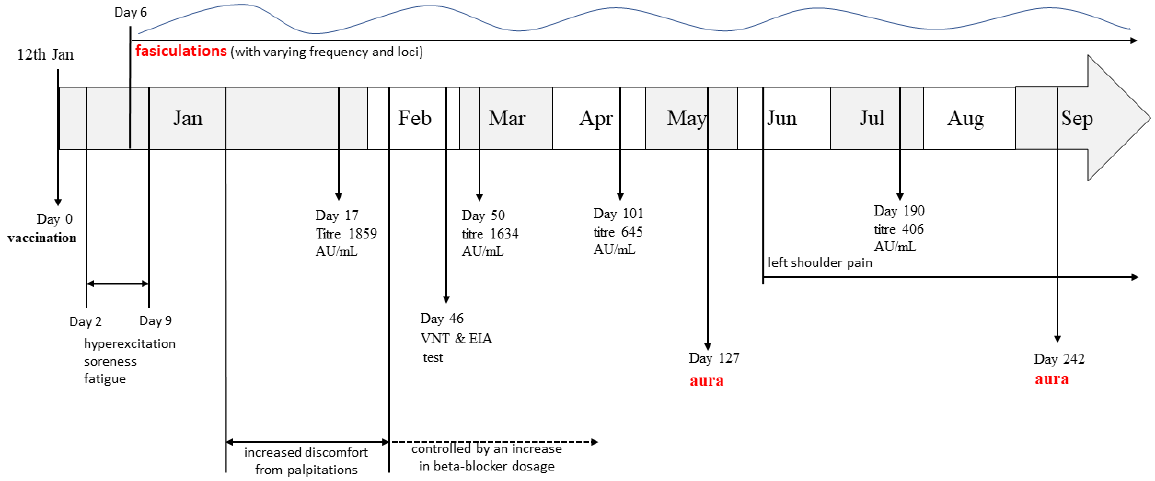
Figure 1. Timeline of the disease course from the point of vaccination (day 0) to the end of Septem- ber. Important events are timed using days post vaccination . Jan—January; Feb—February; Mar— Important events are timed using days post vaccination. Jan—January; Feb—February; Mar—March; March; Apr—April; Jun—June; Jul—July; Aug—August; Sep—September; VNT—virus neutraliza- Apr—April; Jun—June; Jul—July; Aug—August; Sep—September; VNT—virus neutralization tion test; EIA—enzyme immunoassay.